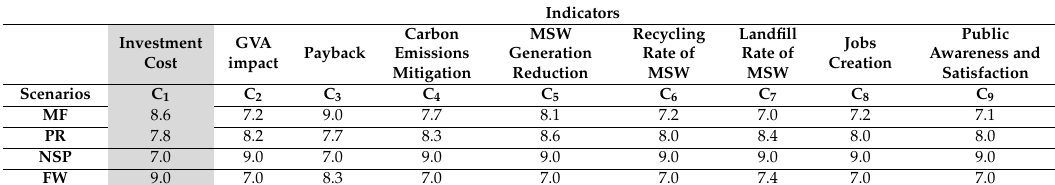
Table 7. Rescaled suggested performance of CE